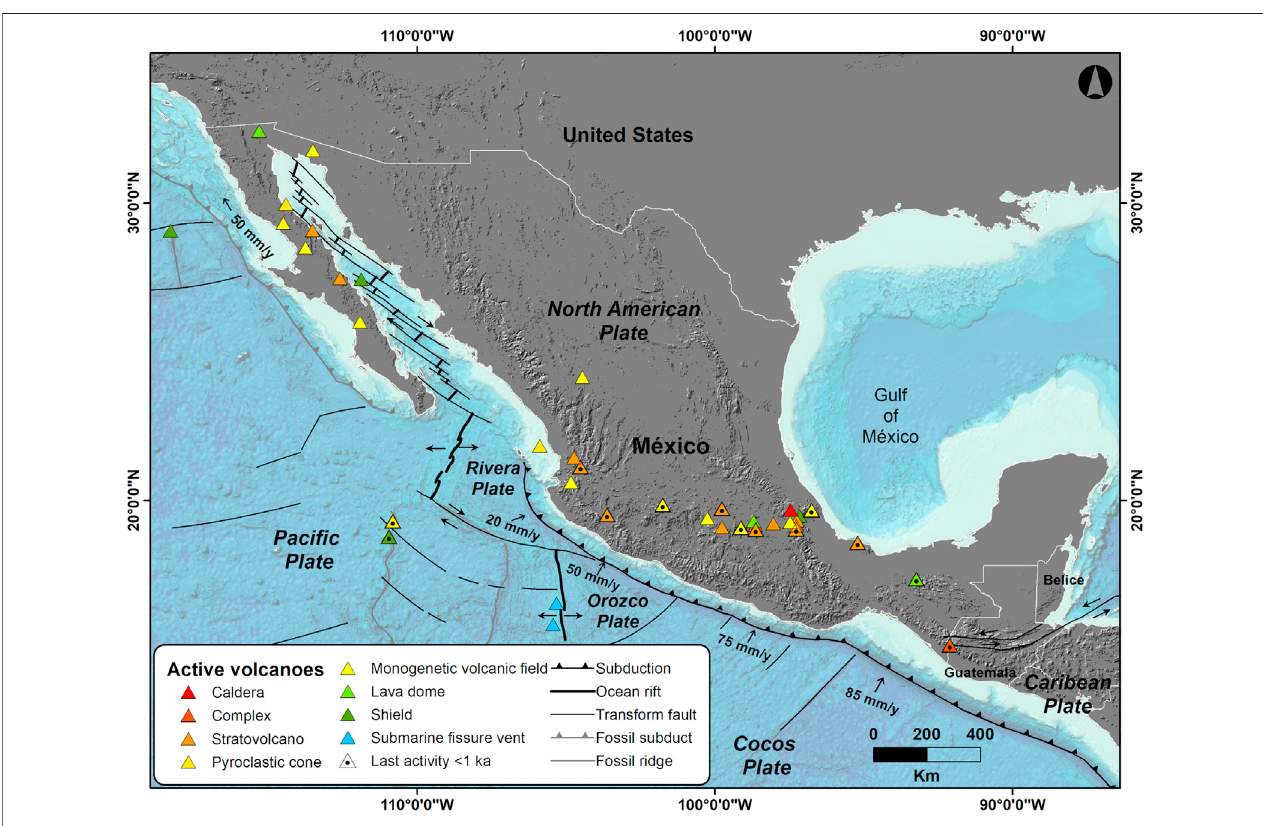
FIGURE 1 | Active volcanoes of México. Tectonic settings from Padilla et al. (2013) are also shown.